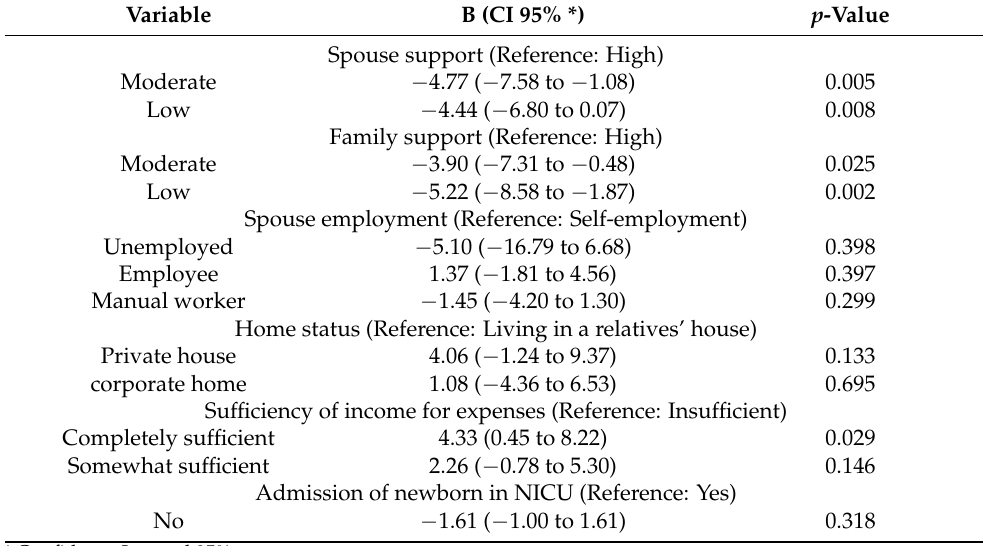
Table 3. Predictors of maternal function based on general linear model ( n =